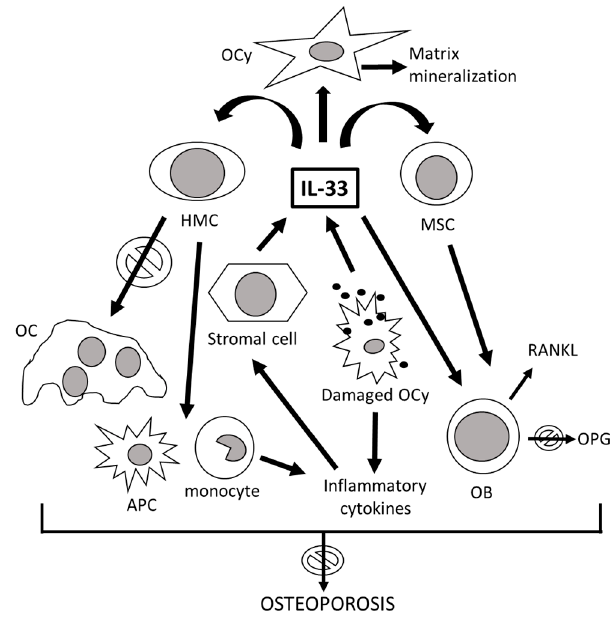
Figure 2. The role of IL-33 in bone remodeling. After inflammatory stimulation, the stromal cells produce IL-33, which directly blocks osteoclast (OC) formation from hemopoietic myeloid cells (HMC), shifting the osteoclast precursor di ff erentiation towards cytokine-producing macrophages and antigen-presenting cells (APC). Damaged osteocytes (OCy), in addition to inducing inflammation, also release IL-33, which in turn stimulates the mineralization of the bone matrix. IL-33 acts directly by stimulating mature osteoblasts (OB) and their bone marrow progenitors, the mesenchymal stem cells (MSC), inducing their di ff erentiation and maturation. Despite the production of the receptor activator of nuclear factor kappa-B ligand (RANKL) and the partial blockage of the production of osteoprotegerin (OPG) by activated osteoblasts, the prevalent e ff ect of IL-33 on the skeleton is anti-osteoporotic. Arrows with “forbidden” signal mean that il-33 has anti-osteoporotic